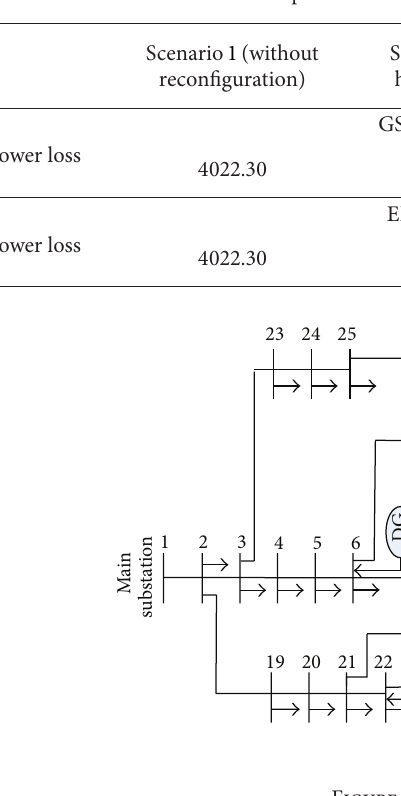
Figure 5: Optimal daily configuration.